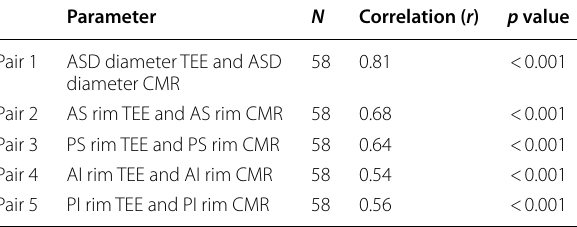
Table 1 Pearson correlation analysis of ASD diameter and rim sizes between TEE and CMR